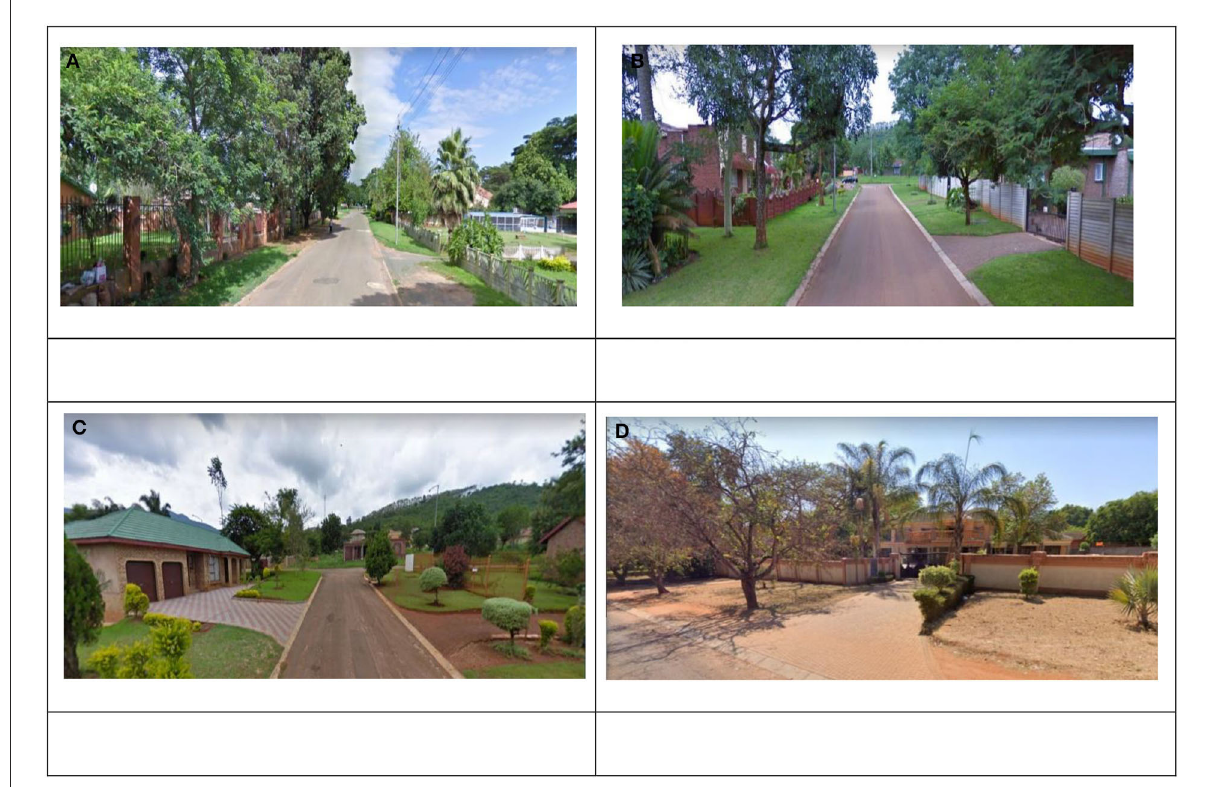
FIGURE3 Pictures of streetscapes in the new town, Louis Trichardt. (A) Mimosa street: low and open fencing/walling. (B) Rietbok street: no fencing, high and closed durawalls/fencing. (C) Leeu street: no fencing—landscaping, gardening, and elevation. (D) Bauhinia street: high strong walls, electric fence, and